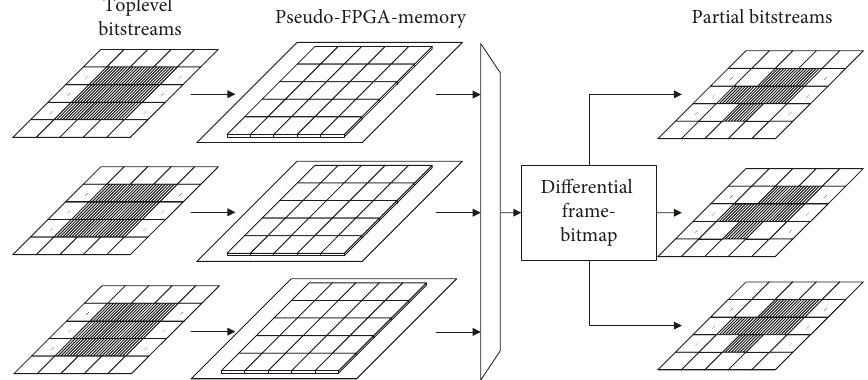
Figure 2: Functionality of the torCombitgen